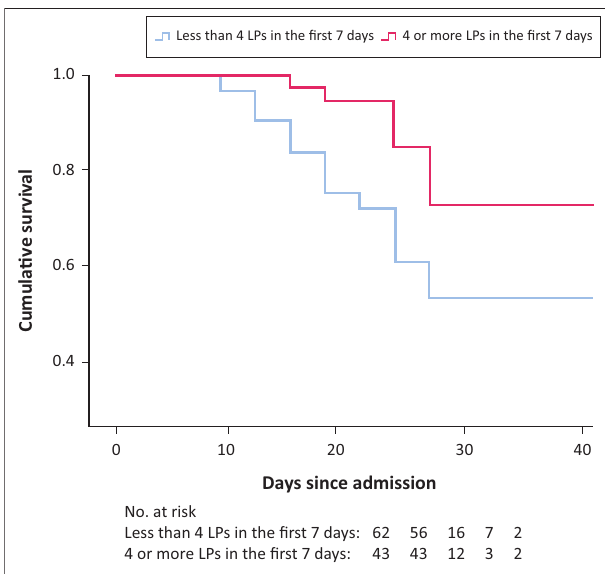
FIG URE 3: Kaplan-Meier estimate of survival amongst patients who received four or more lumbar punctures in the first 7 days of combination antifungal therapy compared with those who received less than four lumbar punctures in the first 7 days of combination antifungal